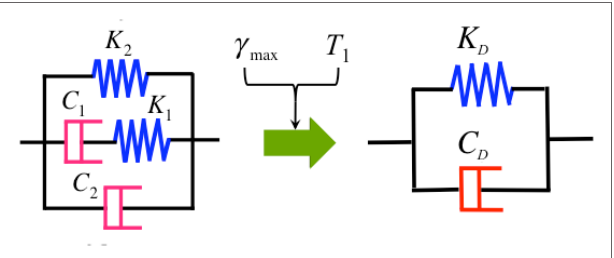
FIGURE 13 | Equivalent linearization of NLF model .